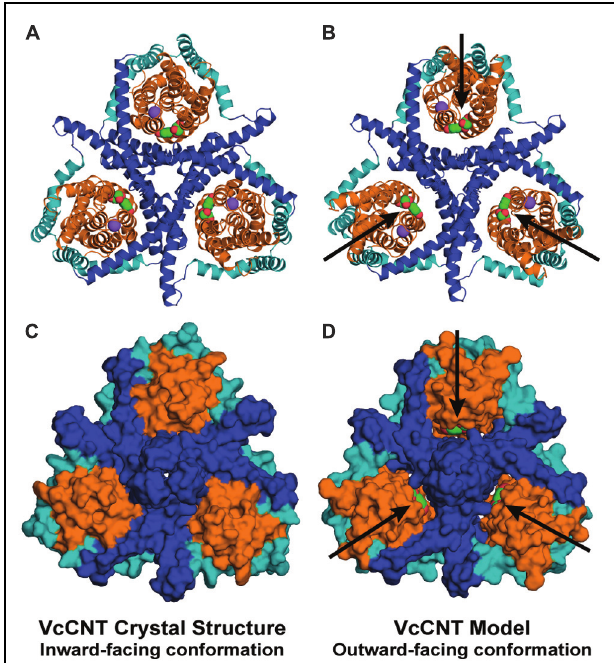
FIGURE 6 | The repeat-swapped model of VcCNT contains an extracellular substrate pathway that is not present in the template structure. The trimeric VcCNT X-ray structure (A,C) and model (B,D) are viewed from the extracellular side, colored according to Figure 1 and rendered either as cartoon helices (A,B) or using the van der Waals surface (C,D) . The substrate ( spheres, arrows ) is visible from the extracellular side in the model (D) , but not in the inward-facing crystal structure (C)